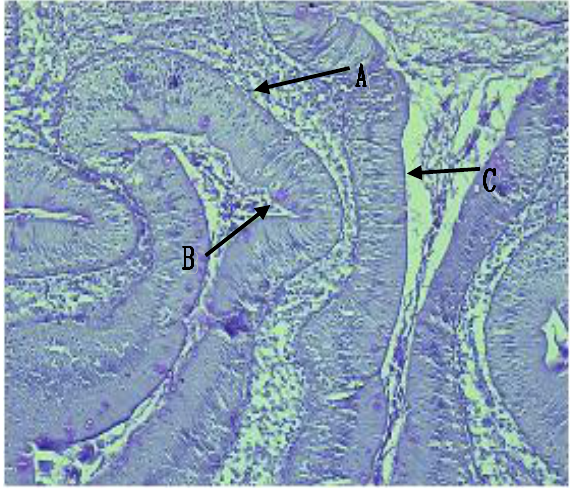
Figure, 2: Cross microscopic section of posterior portion of intestine of common carp, (A)mucosa, (B)submucosa, (C)muscularis, (D)serosa, (E)fold, H & E stain (X40).